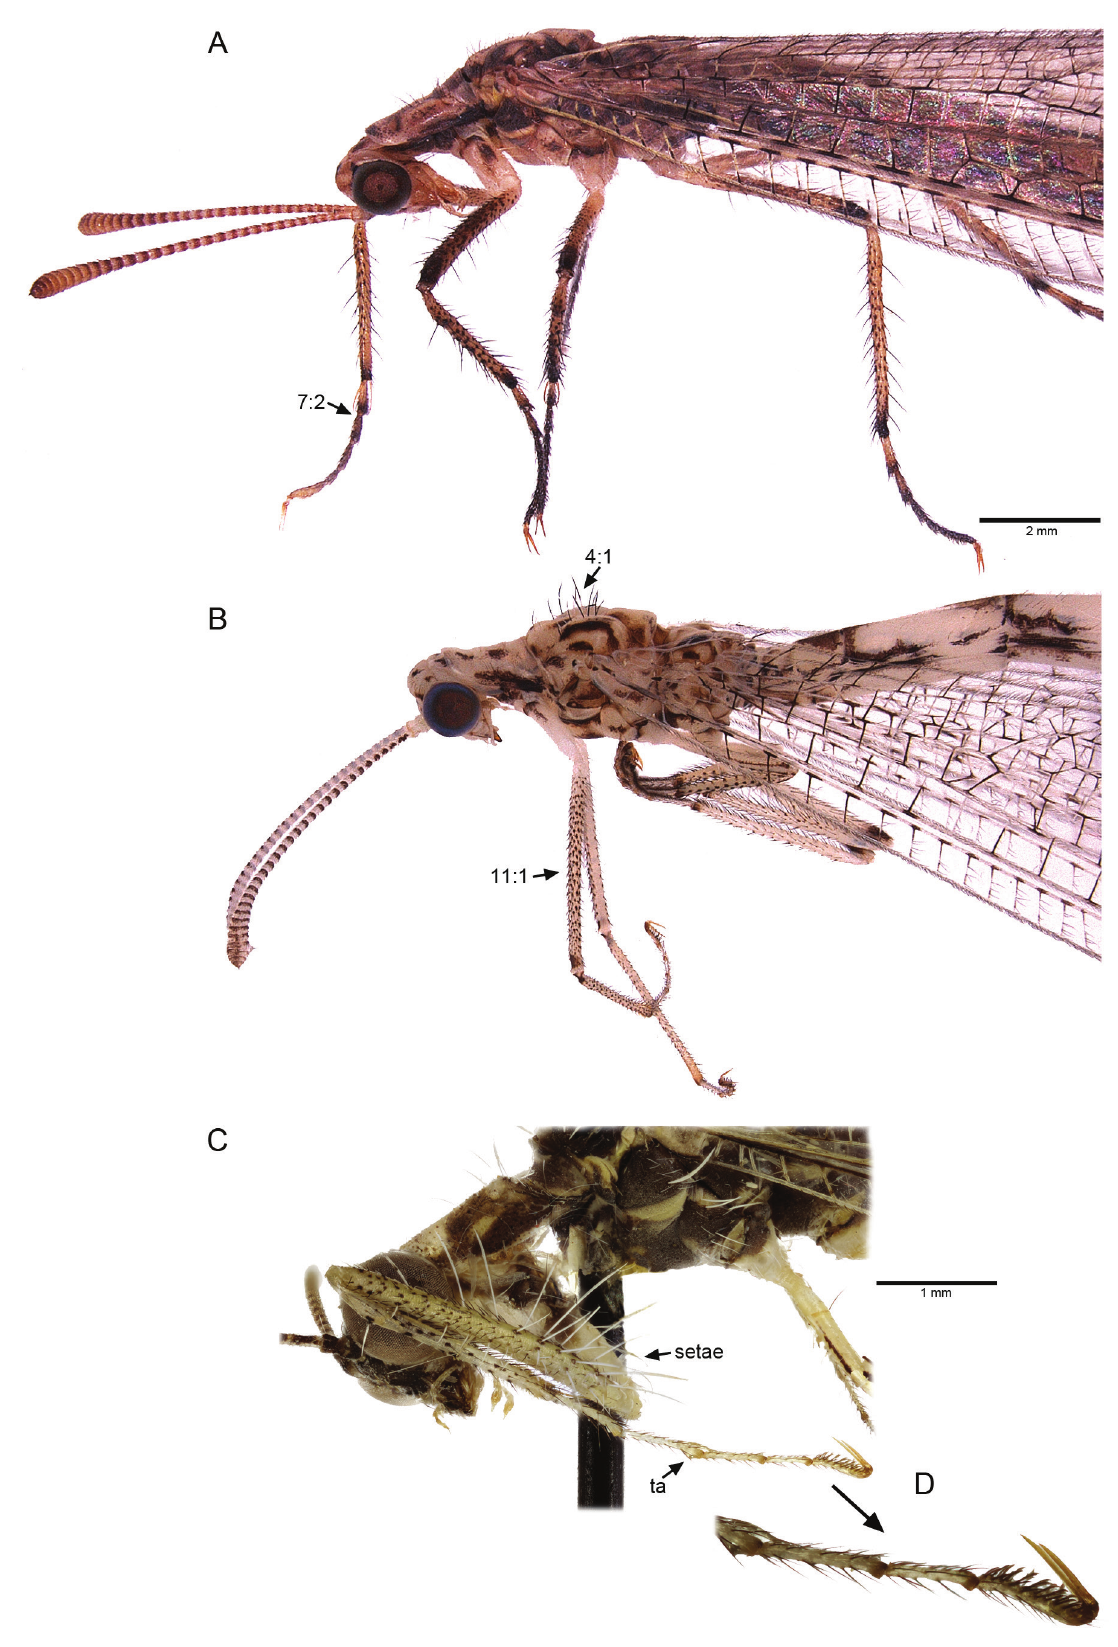
Figure 1. Gymnocnemia and Megistopus , habitus and details of thorax, lateral view. A Megistopus lucasi [Italy, Sardinia]; B Gym - nocnemia variegata [Greece, Corfu]; C–D Gymnocnemia mirabilis [Oman, Jabal Shams], C thorax and prothoracic leg, D tarsus. Numbers indicate morphological characters of the data matrix and their state. Abbreviation: ta –